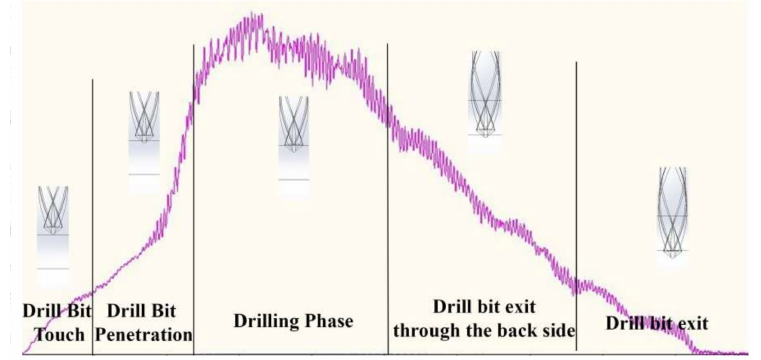
Figure 3. Typical thrust force